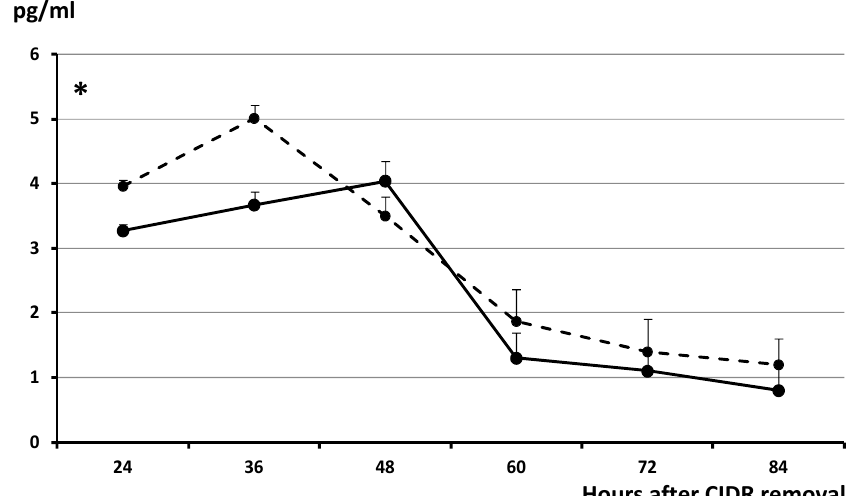
Figure 2. Mean (± SEM) plasma estradiol concentrations in sheep treated with Controlled Internal Drug Release (CIDR) devices for five days and 400 IU of eCG at CIDR removal +5 mg of prostaglandin F2 α (Group eCG; discontinuous line) or 500 IU of hCG at 24 h after CIDR removal (Group hCG; continuous line). Asterisk denotes significant difference ( p < 0.05). Data from ewes with high estradiol levels at 84 h were excluded (one ewe in Group eCG, with 11.4 pg/mL, and three ewes in Group hCG, with 27.9, 21.0, and 12.9 pg/mL).